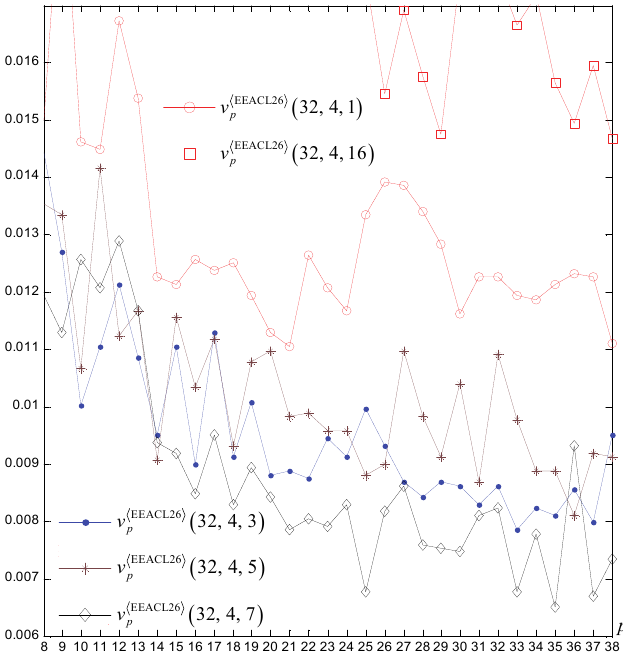
Fig. 18. Error rates against 38 epochs for the EEACL26 dataset. The best gain is achieved at the version of k = 7, not of k = 3. The two DOLs seem to win.